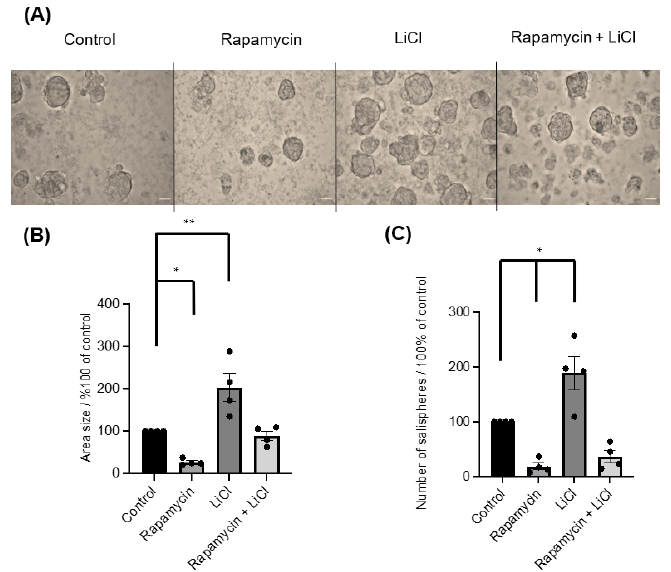
Figure 2. ( A ) Images of untreated salispheres (control) and salispheres treated with rapamycin, LiCl, and the combination of rapamycin and LiCl (Rapamycin + LiCl). ( B ) A significant reduction in the area size of the salispheres appeared after rapamycin (* p < 0.05) treatment and a significant increase in the area size appeared after LiCl treatment compared to the control (** p = 0.0064). A recovery in the size of the salispheres was observed in the rapamycin–LiCl cotreatment ( p = 0.9684). ( C ) Numbers of cultured salispheres were enormously affected by rapamycin alone (* p < 0.05), while they improved when LiCl was combined with rapamycin ( p = 0.0779). At the same time, a substantial increase in the number of salispheres was observed in salispheres treated with LiCl only (* p < 0.05) ( n = 4). The scale bar represents 100 μ m. Data are expressed as mean ± S.E.M ( n = 4).